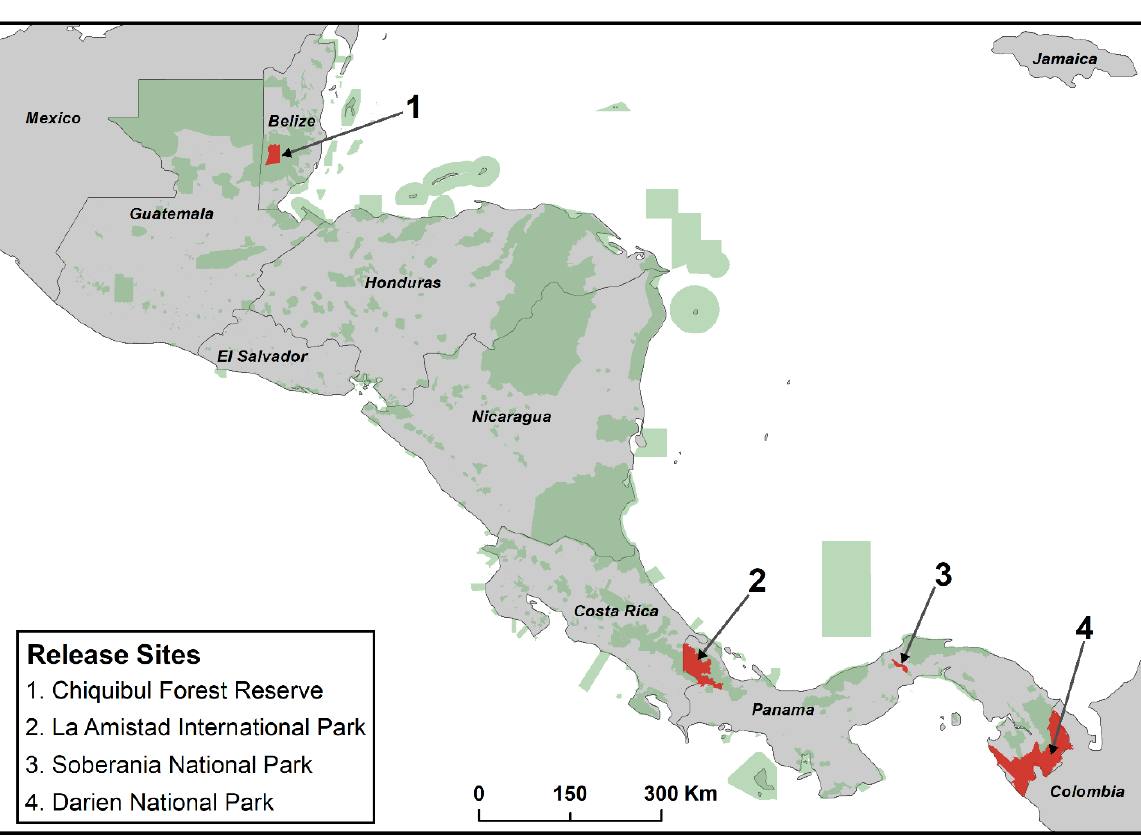
Figure 1. Location of release sites of captive-reared and wild-rehabilitated Harpy Eagles ( Harpia harpyja ) in Central American landscapes. Protected areas are indicated in green. Protected areas where eagles were released are highlighted in red.